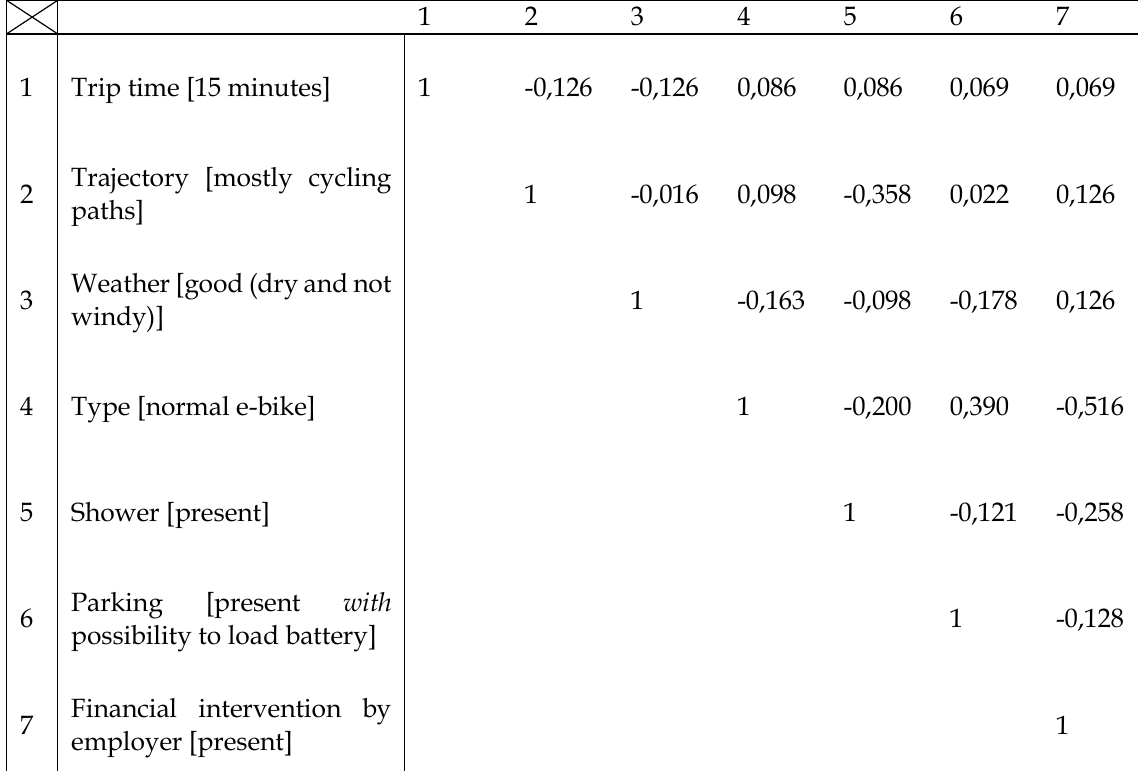
Correlation matrix of the parameter estimates of the binomial logit